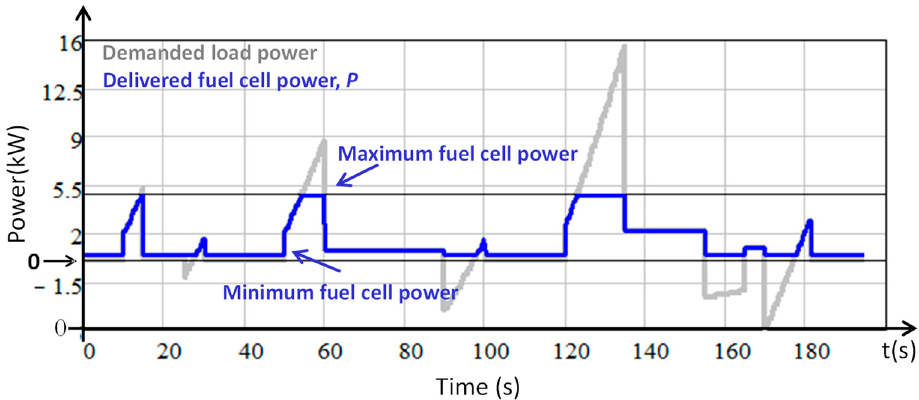
Figure 4. Fuel cell-delivered power: a minimum value of 400 W and maximum value of 4.7 kW for the ECE-15 profile applied to a light vehicle.